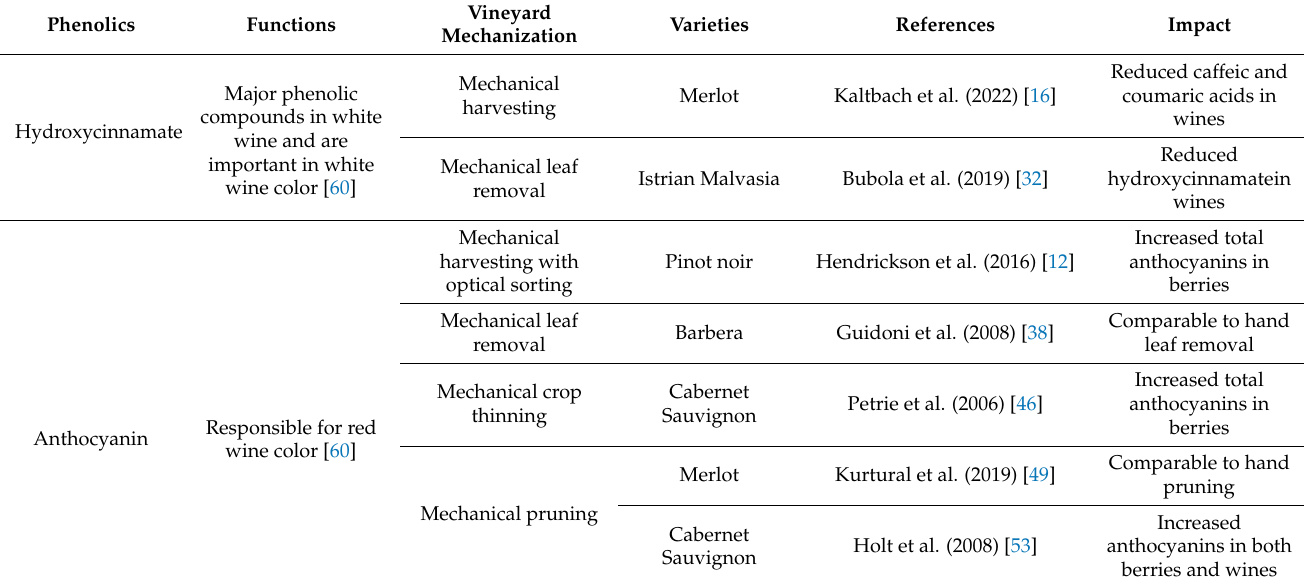
Table 1. The impact of vineyard mechanization on grape and wine